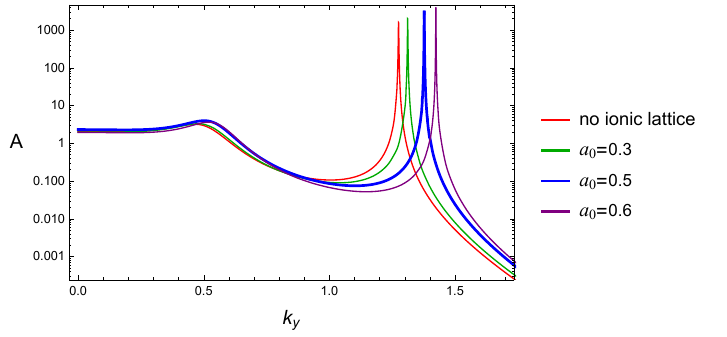
Figure 13 . The MDF along the k y -axis for varying values of the amplitude of the ionic lattice for (cid:12)xed ! = 10 (cid:0) 6 , q = 2 and T = 0 : 01426. The case with a 0 = 0 : 5 is denoted by a thick blue curve. The (cid:12)rst Brillouin zone boundary is at k x =